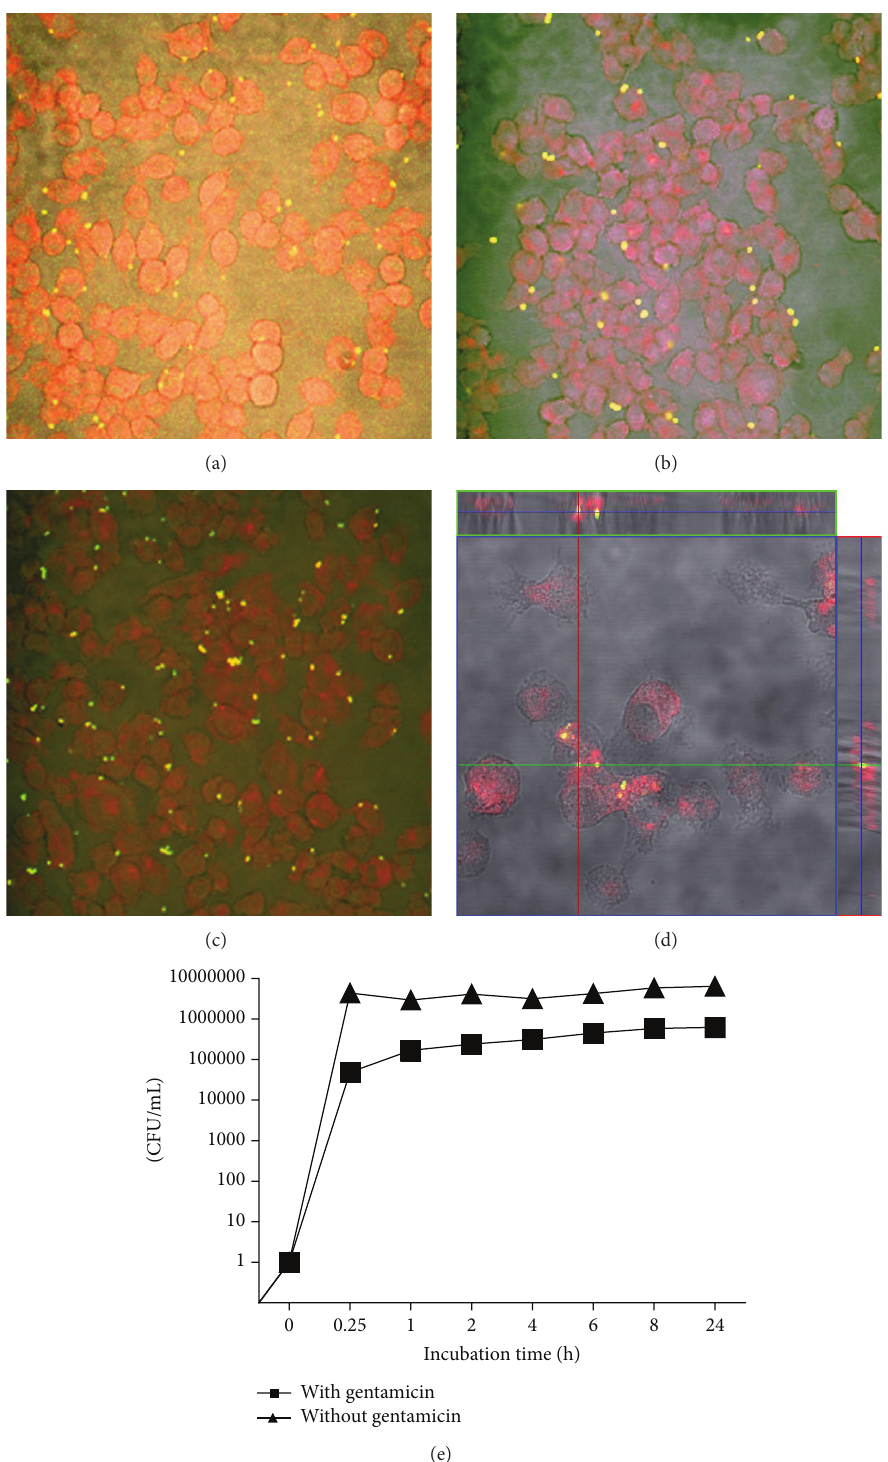
Figure 1: Gonococcus uptake by murine macrophage cell line: fluorescence micrograph of murine macrophage cell line RAW 264.7 incubated with GFP-expressing Neisseria gonorrhoeae (green) variant P9-17 for (a) 1h, (b) 2h, (c) 3h, and (d) orthogonal view of the intracellular gonococci (green spots); a midplane 𝑍 -section of height 1.25 𝜇 m is shown. Phase contrast denotes cell boundaries. Nuclei are in red. (e) Gentamicin protection assay for infection of RAW cells with N. gonorrhoeae variant P9-17 ( 𝑛 = 3